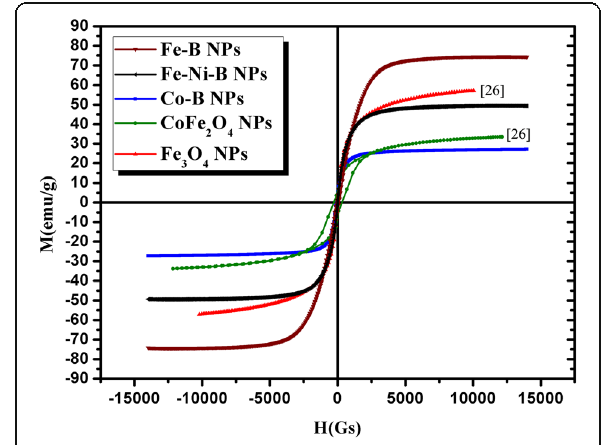
Fig. 1 XRD patterns of Fe-B, Fe-Ni-B, and Co-B particles